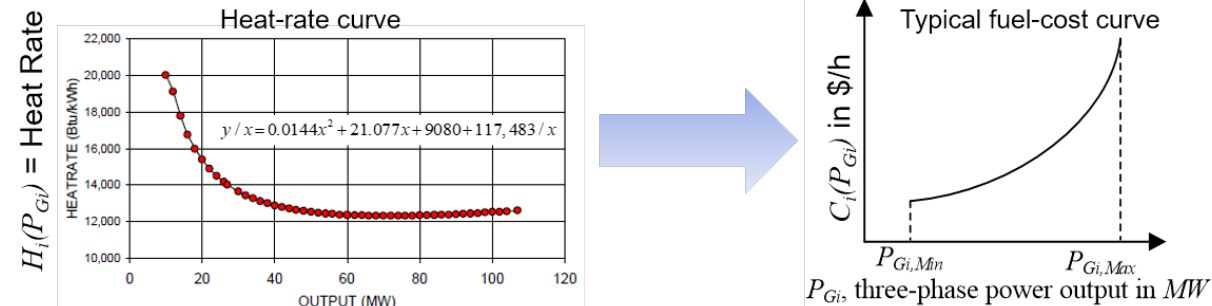
Figure 3. Typical fuel–cost curve for steam generation [13].